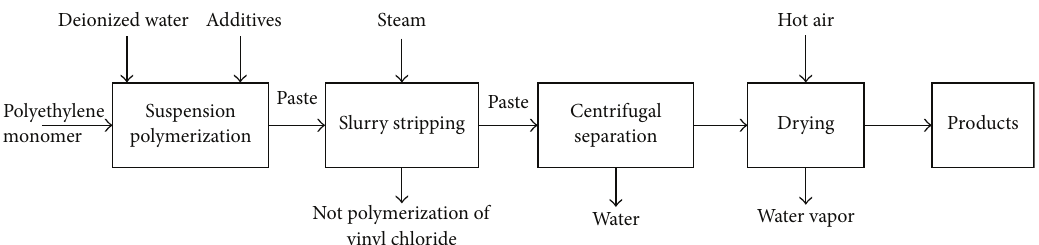
Figure 1: Flowchart of suspension polymerization.